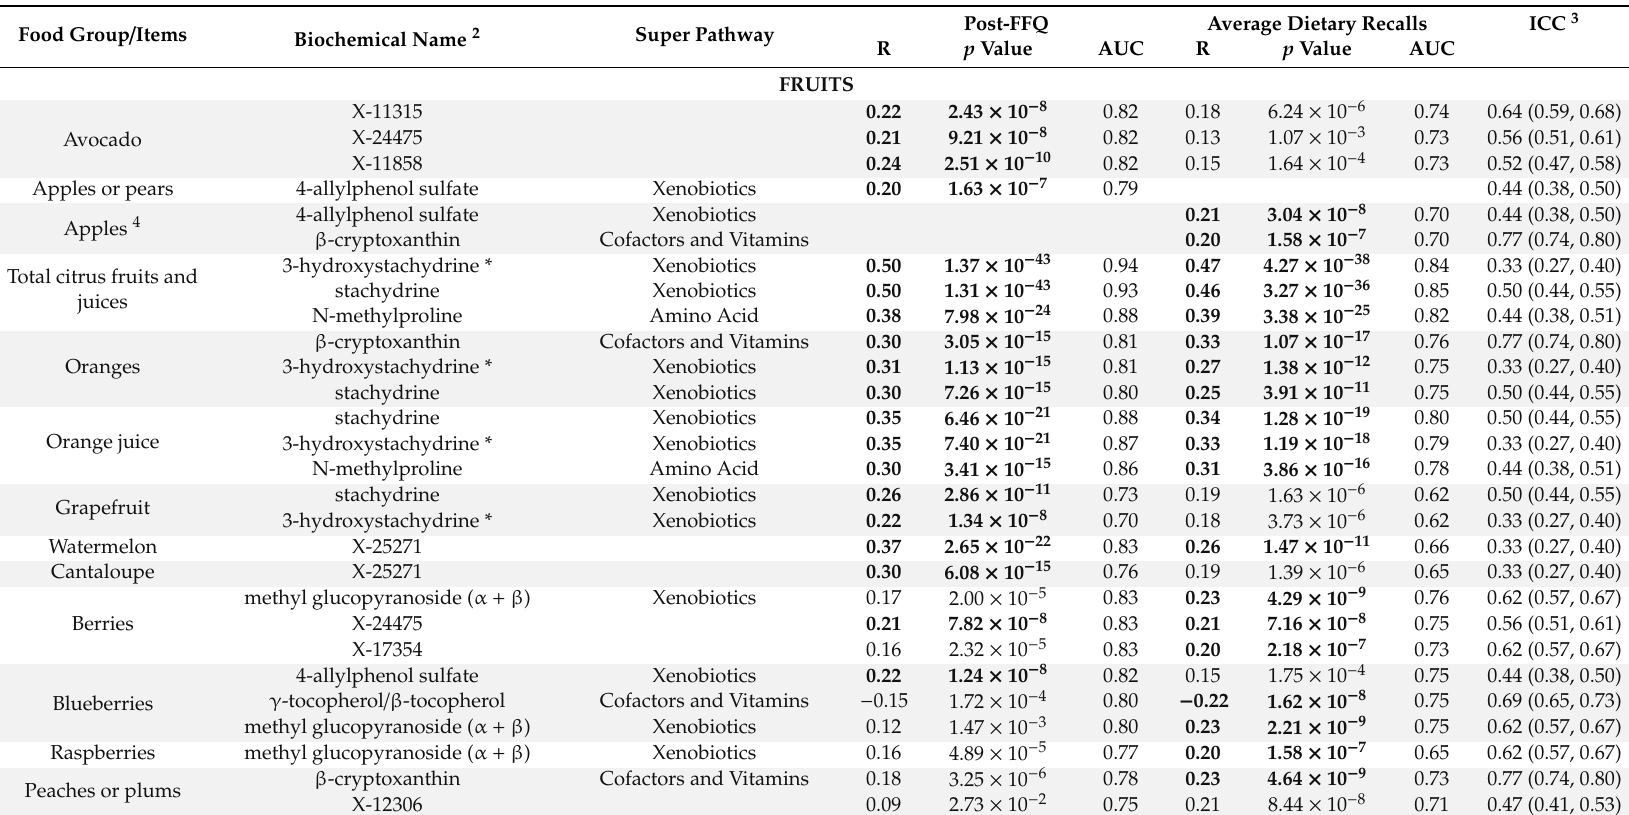
Table 2. Top three predictive metabolites for 74 food group / item assessed using the CPS-3 FFQ and average of 24-h diet recalls in the Cancer Prevention Study-3 Diet Assessment Sub-study 1